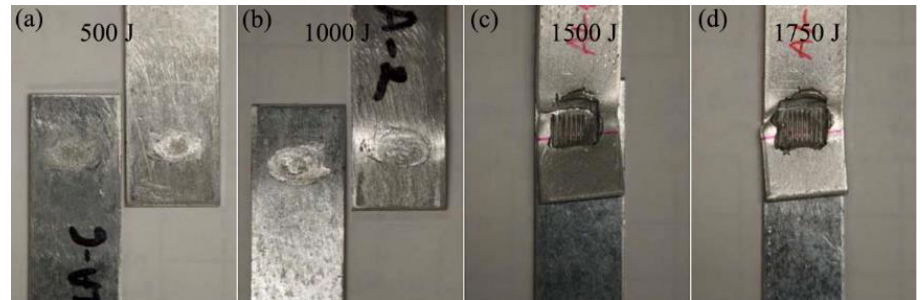
Figure 23. Tensile failure locations of Al-6061-to-galvanized-HSLA-steel with an increase in the welding energy [38]: ( a ) 500 J; ( b ) 1000 J; ( c ) 1500 J; ( d ) 1750 J.